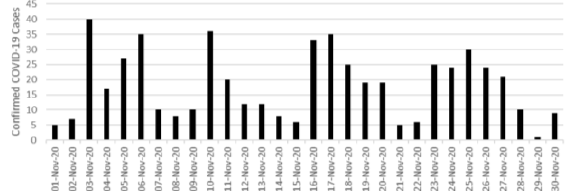
Figure 7. Daily cases in Taguig City from 11/ 01 to 11/30,